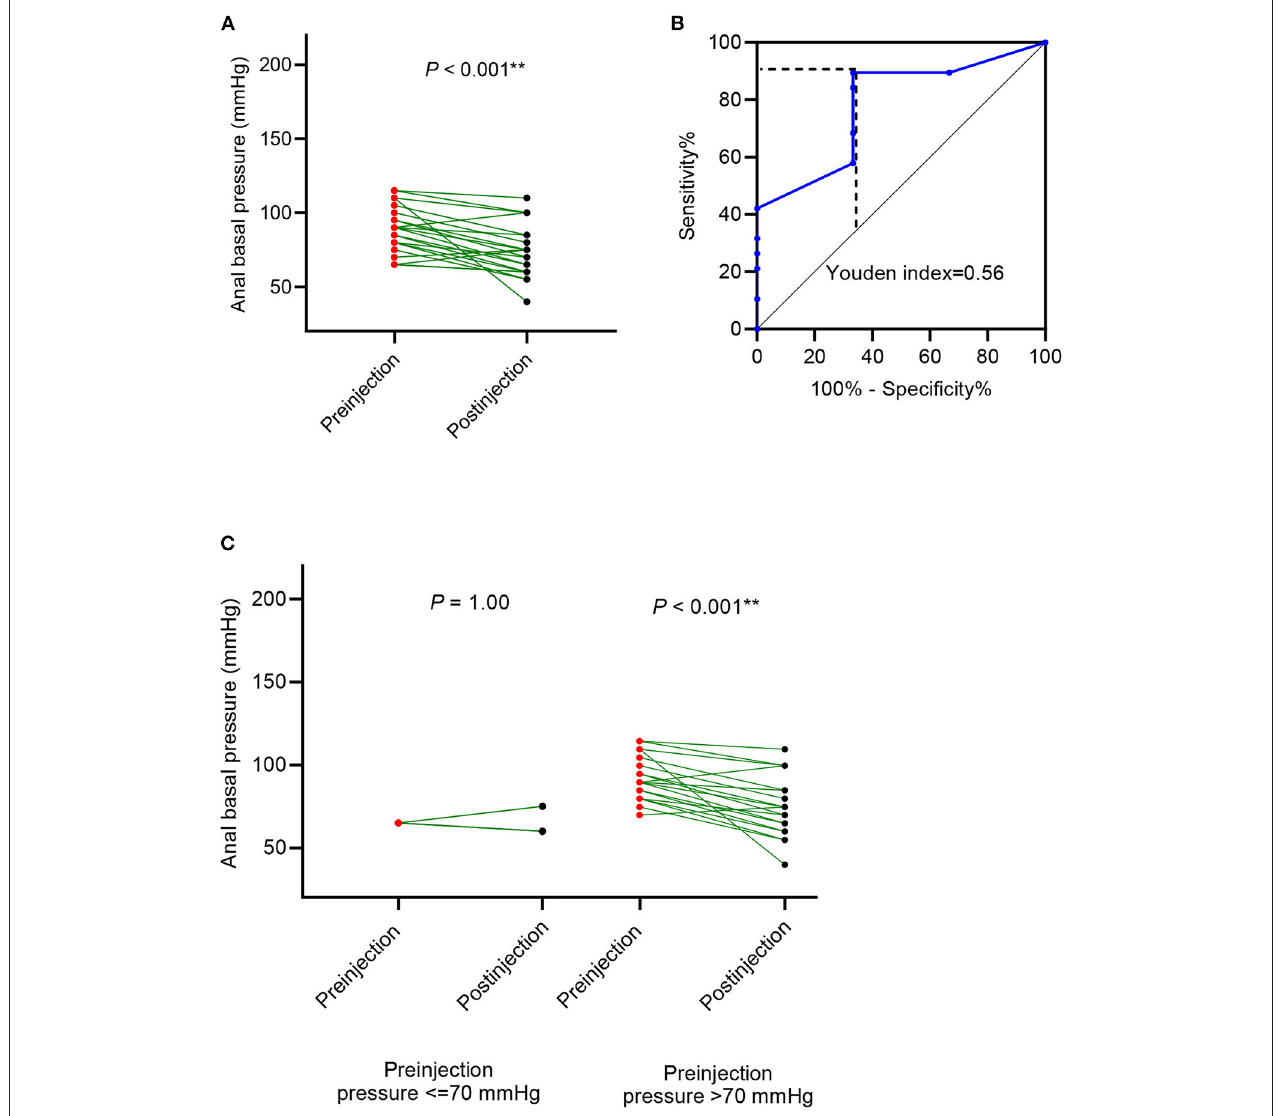
FIGURE 4 | Anal basal pressure change after botulinum toxin injection in patients with organic disorders, such as Hirschsprung’s disease (HD) and congenital anorectal malformations (CARM). (A) The change in anal basal pressure after botulinum toxin injection; (B) receiver operating characteristic (ROC) curve using preinjection anal basal pressure to predict the decrease of anal basal pressure decrease; (C) comparison of anal basal pressure before and after the botulinum toxin injection in patients whose anal basal pressure before injection was ≤ 70 mmHg and > 70